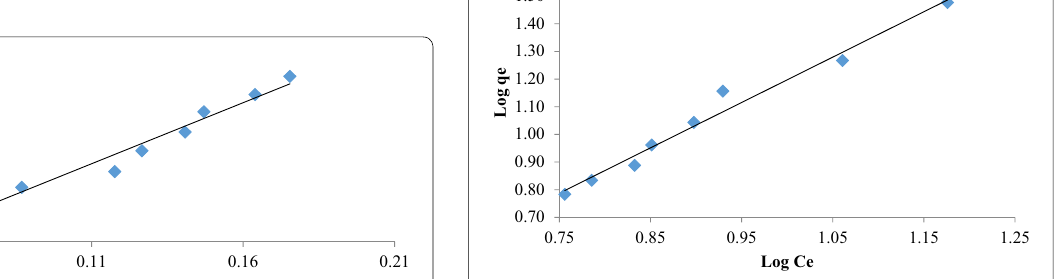
Fig. 3 Freundlich isotherm plot for fluoride removal from aqueous solution using